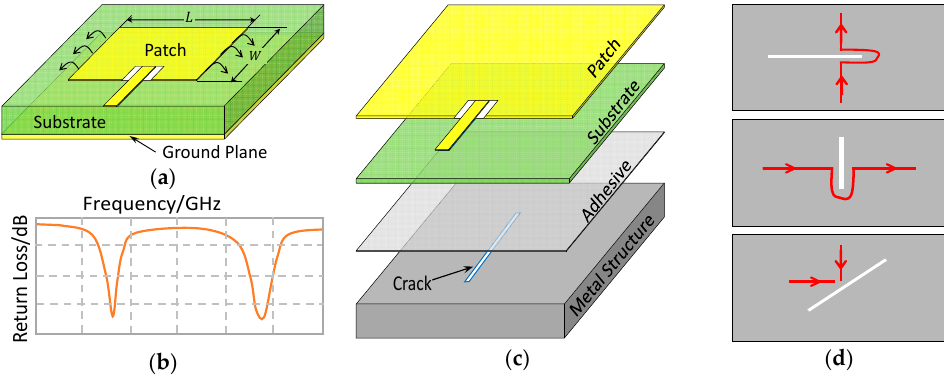
Figure 1. Crack detection mechanism of the patch antenna sensor. ( a ) configuration of a patch antenna; ( b ) S 11 curve representing the radiation characteristics of a path antenna; ( c ) patch antenna used on metal structure as a sensor; ( d ) impact of cracks on the sensor’s current pattern.